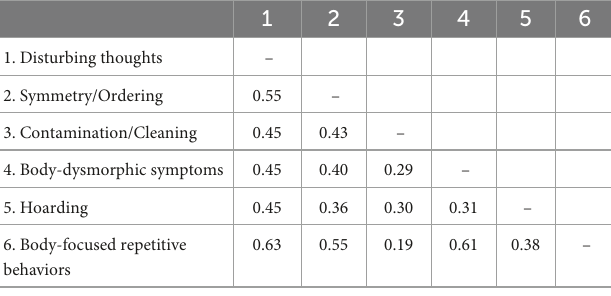
TABLE 4 CFA-based standardized covariance coefficients among the OCRD-D-E